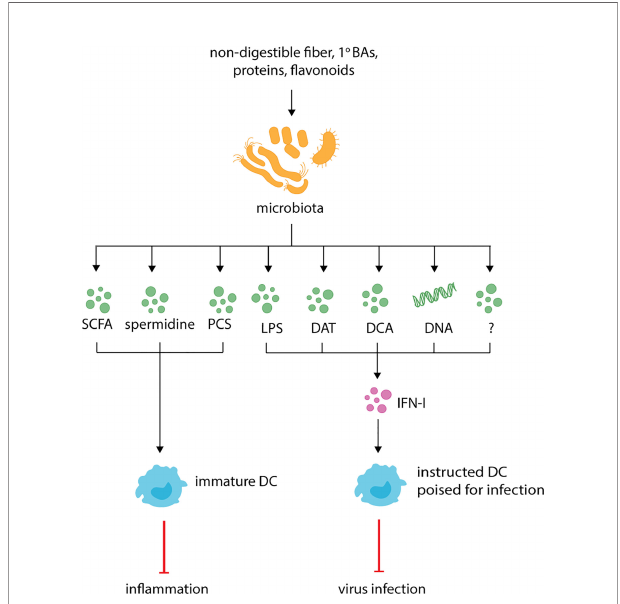
FIGURE 1 | Microbiota derived metabolites regulate DC function and respiratory health. The microbiota produces known metabolites and cell components such as short-chain fatty-acids (SCFAs), p -cresol sulfate (PCS), desaminotyrosine (DAT), deoxycholic acid (DCA), lipopolysaccharide (LPS) and currently uncharacterized metabolites (indicated by the question mark). During in fl ammation, SCFAs, spermidine and PCS dampen in fl ammation by promoting the generation of functionally immature DC which dampen Th2 responses. At steady-state, LPS, DAT, DCA, microbiota-derived DNA and potentially other uncharacterized metabolites instruct DCs for future immune responses by promoting the production of